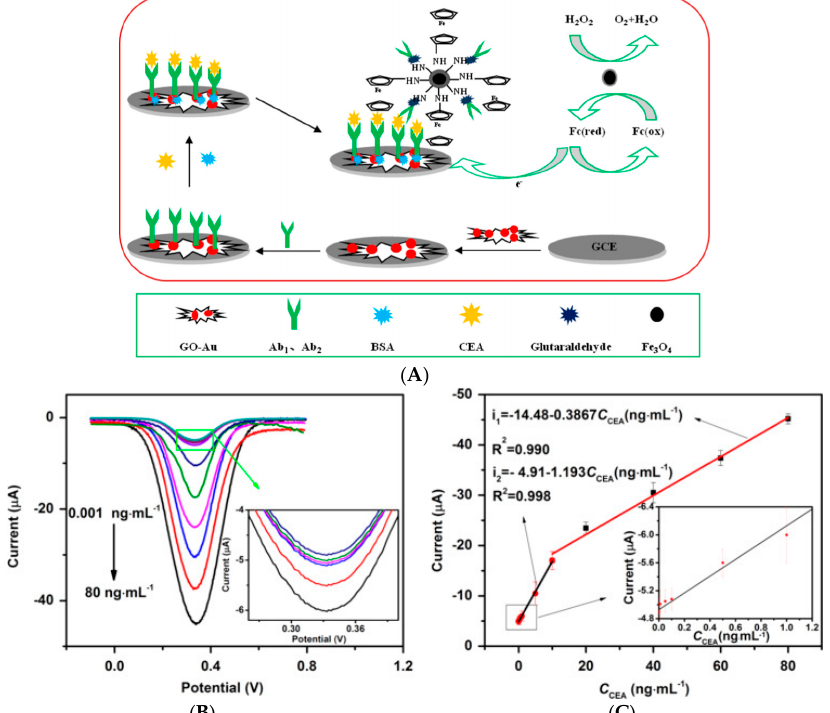
Figure 12. ( A ) Fe 3 O 4 @SiO 2 –Fc–Ab 2 /HRP particles for enzyme-less catalytic immunodetection of CEA.